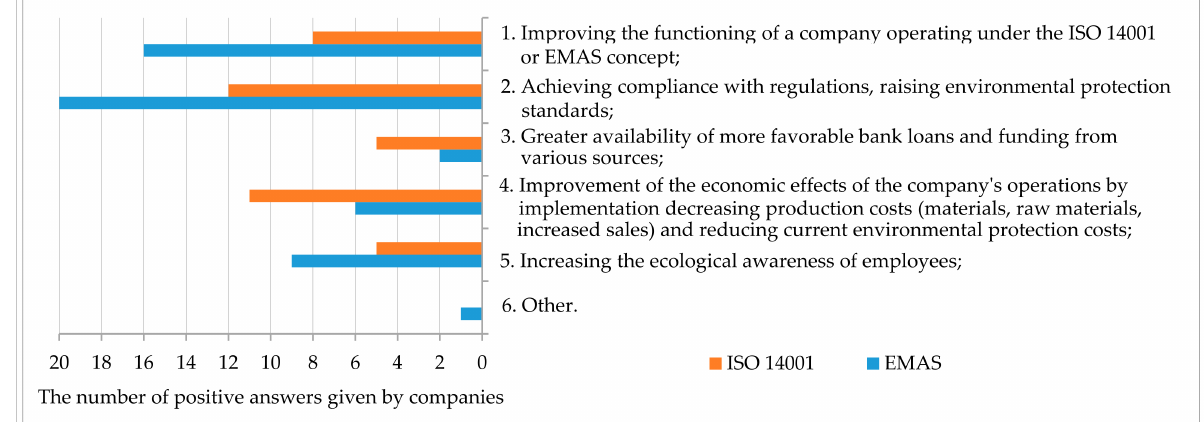
Figure 3. Answers to the third question of the survey: Internal benefits stemming from EMAS/ISO14001